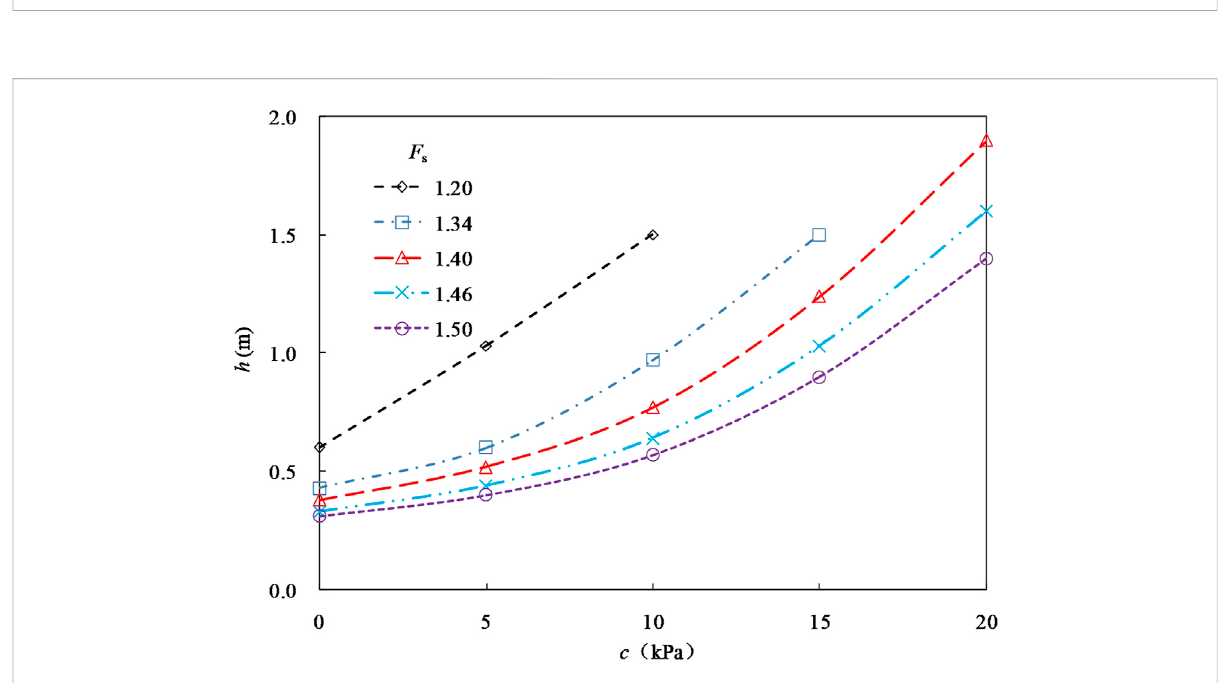
FIGURE 11 Relationship between h and c under different F s